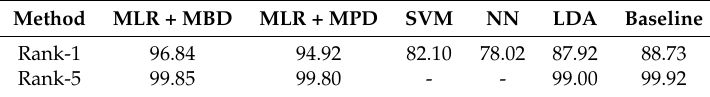
Table 3. Method performance for all beat classes on MLII.